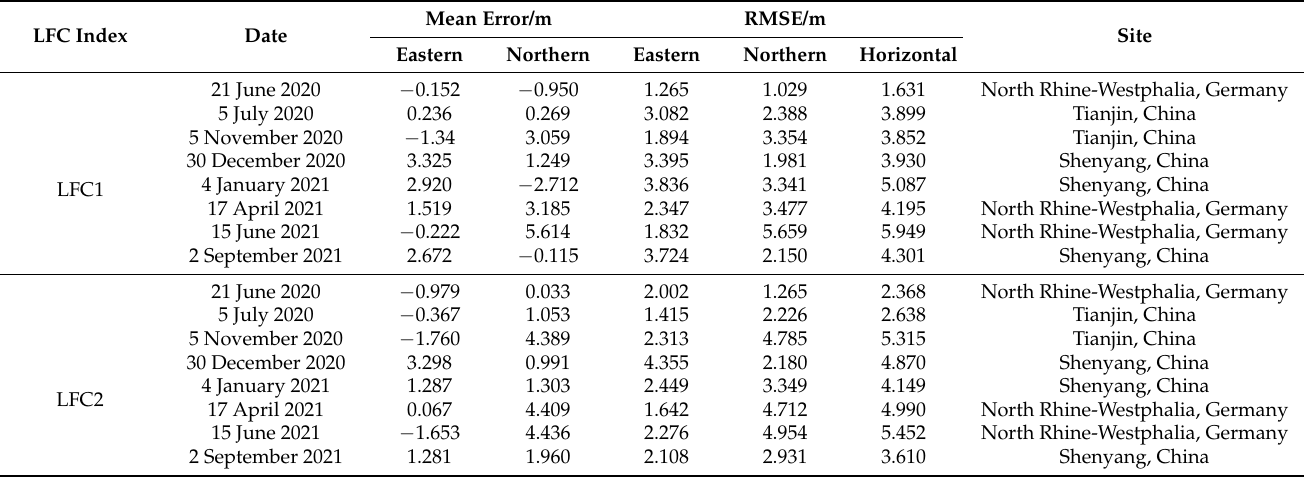
Table 7. Validation results with high accuracy reference